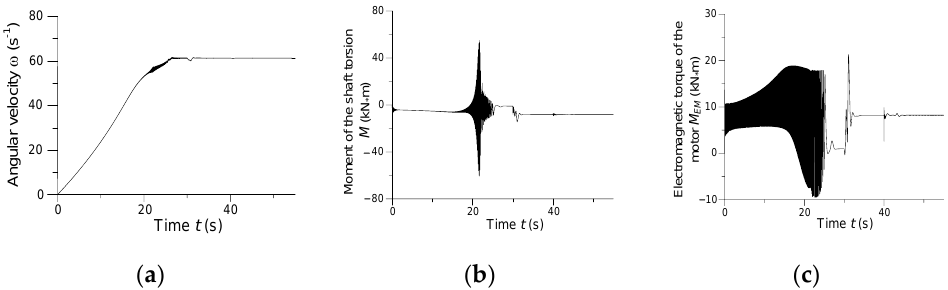
Figure 17. Instantaneous waveforms of: ( a ) the angular velocity of the synchronous drive rotor; ( b ) moment of torsion in the middle section of the synchronous drive’s long motion transmission shaft; and ( c ) electromagnetic torque of the synchronous motor.